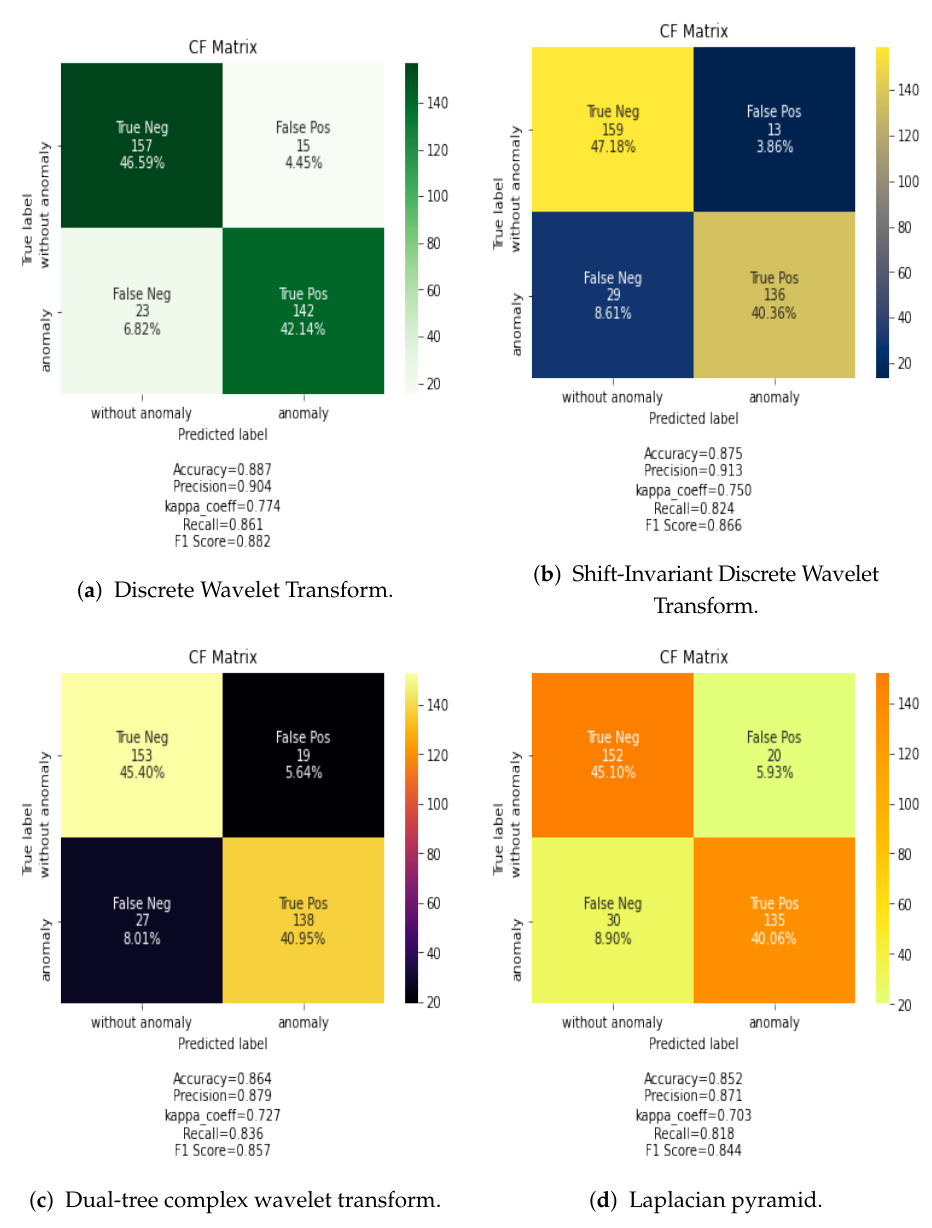
Figure 6. Confusion Matrix of reults for frequency data fusion methods combined with the CNN